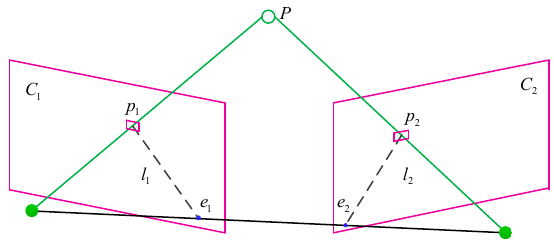
Figure 4. Constraints on the polar geometry.